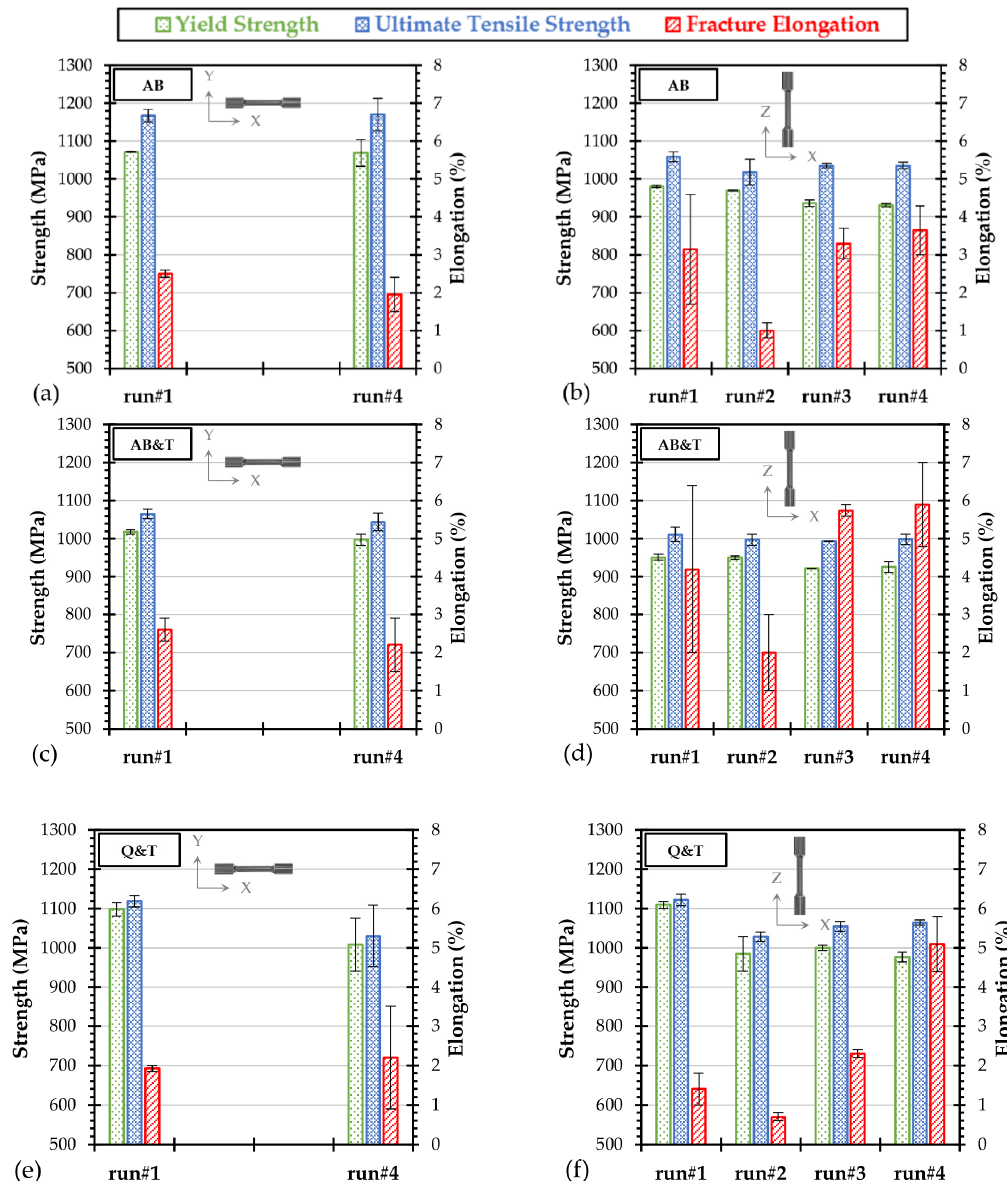
Figure 5. Orientation-related tensile properties of the W-4130 steel processed after powder recycling and tested in ( a , b ) AB, ( c , d ) AB & T, and ( e , f ) Q & T conditions. The average degree of anisotropy in both ultimate tensile strength and fracture elon- gation has been quantitatively evaluated by considering the ratio between horizontal and vertical properties. A low degree of anisotropy in tensile strength (around 1.12 ± 0.02) was measured for the as-built specimens, since the horizontal specimens always provided higher yield and ultimate tensile strength values, while better ductility (0.66 ± 0.18) was detected for the vertical loading direction. This anisotropy in strength could be reduced to 1.05 ± 0.01 after performing a direct tempering treatment at 550 ◦ C, or even down to 0.98 ± 0.02 after applying the conventional Q & T treatment. However, the direct tempering resulted in an increased ductility anisotropy to reach a value of 0.50 ±